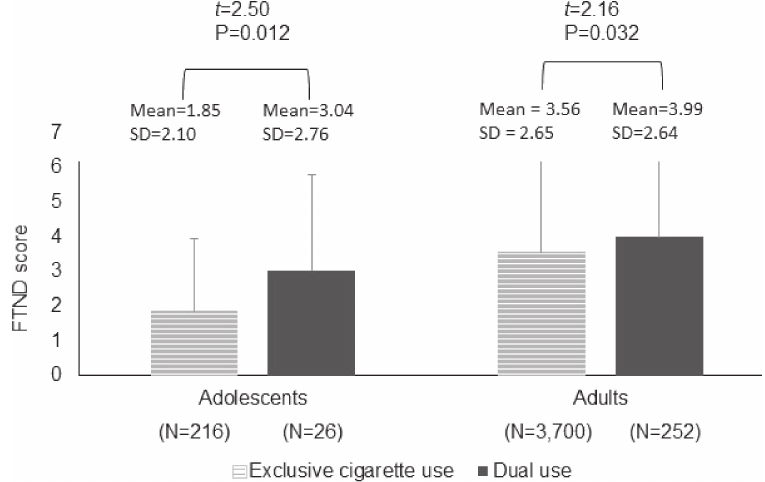
Figure 2. Comparing the distribution of the score on the 6-item Fagerstrom Test for Nicotine Dependence (FTND) between people with exclusive cigarette use and those with dual use in adolescents and adults,